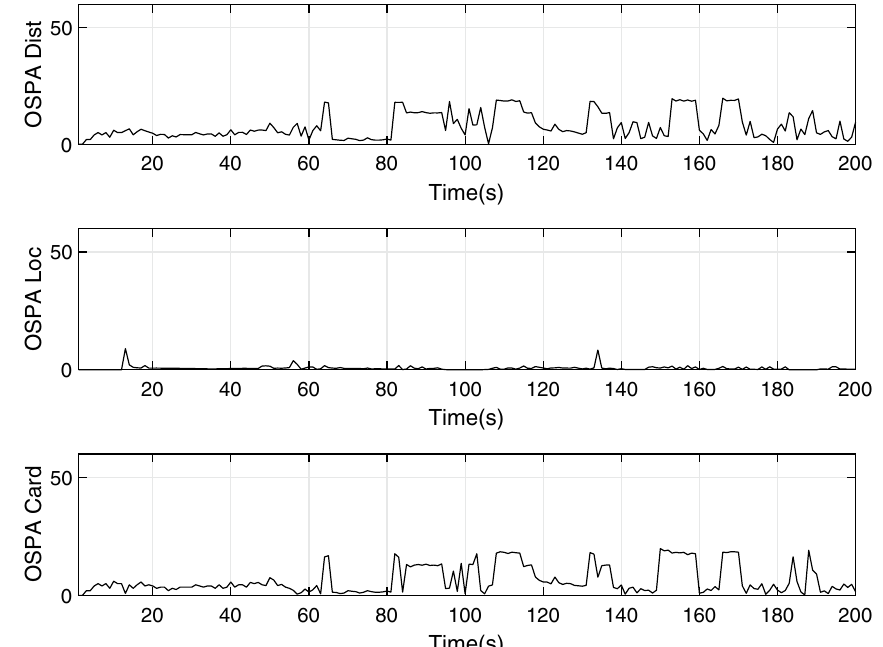
Fig. 7 The OSPA error (50MCs). Only considering the detected